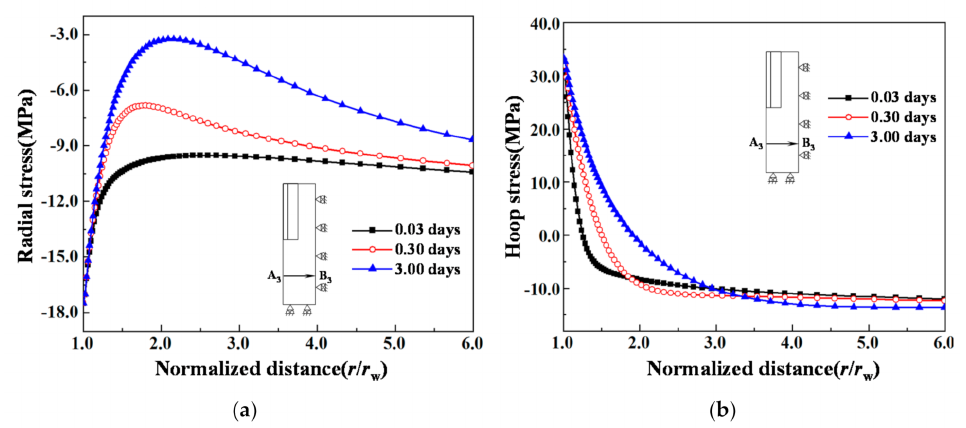
Figure 9. Variations of the stress with time on section A 3 B 3 : ( a ) radial stress; ( b ) hoop